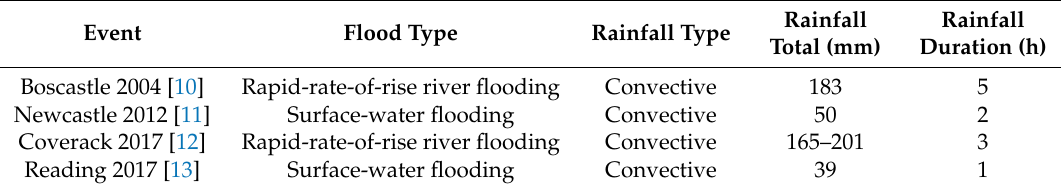
Table 1. Examples of UK rainfall events that led to flooding from intense rainfall, and the type of flooding it led